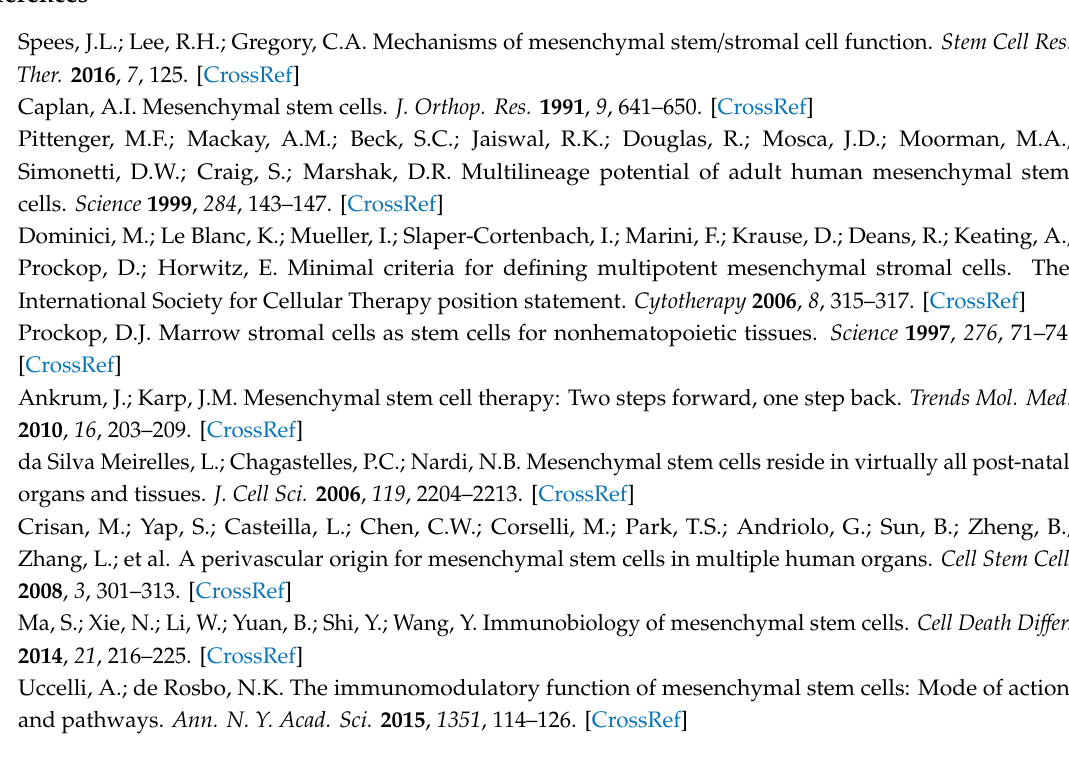
Figure S5: Spheroids generated from extensively expanded MSCs from donor 2 secrete high amounts of TSG-6. Spheroids and very high density monolayer MSCs were cultured in FBS-containing media and in xeno-free media from MSCs after passages 3, 5, and 7. The conditioned medium was harvested after three days for TSG-6 ELISA. Spheroids were also dissociated, and the resulting cells were tested for their ability to maintain TSG-6 secretion. (A) TSG-6 secretion by spheroids and very high density monolayer MSCs in FBS-containing media and xeno-free media at di ff erent passages. (B) TSG-6 secretion by spheroid-derived cells from FBS-containing media and xeno-free media at di ff erent passages. Figure S6: Spheroids generated from extensively expanded MSCs from donor 1 secrete high amounts of STC-1. Spheroids and very high density monolayer MSCs were cultured in FBS-containing media and in xeno-free media from MSCs after passages 3, 5, 7, and 9. The conditioned medium was harvested after three days for STC-1 ELISA. Spheroids were also dissociated, and the resulting cells were tested for their ability to maintain STC-1 secretion. (A) STC-1 secretion by spheroids and very high density monolayer MSCs in FBS-containing media and xeno-free media at di ff erent passages. (B) STC-1 secretion by spheroid-derived cells from FBS-containing media and xeno-free media at di ff erent passages. Figure S7: Spheroids generated from extensively expanded MSCs from donor 2 secrete high amounts of STC-1. Spheroids and very high density monolayer MSCs were cultured in FBS-containing media and in xeno-free media from MSCs after passages 3, 5, and 7. The conditioned medium was harvested after three days for STC-1 ELISA. Spheroids were also dissociated, and the resulting cells were tested for their ability to maintain STC-1 secretion. (A) STC-1 secretion by spheroids and very high density monolayer MSCs in FBS-containing media and xeno-free media at di ff erent passages. (B) STC-1 secretion by spheroid-derived cells from FBS-containing media and xeno-free media at di ff erent